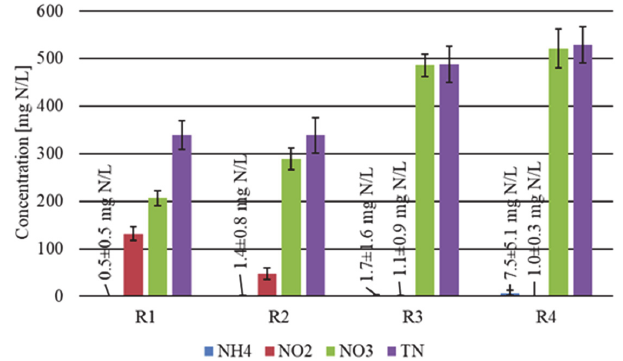
Figure 2. Concentration of various nitrogen forms in BER effluent.